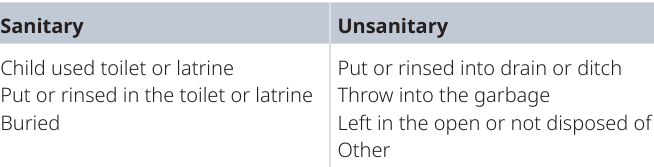
Table 2. Joint Monitoring Programme classification of sanitary and unsanitary disposal of children stool 31 . Please note this table